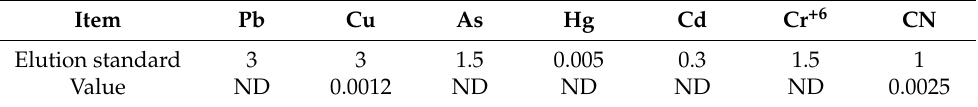
Table 13. Results of heavy-metal leaching test according to the waste-management law (unit: